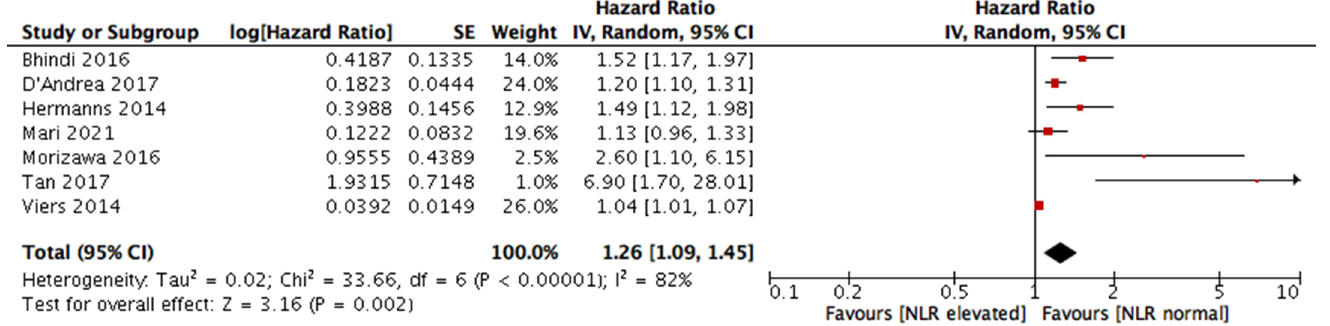
Figure 2. Meta-analysis results of neutrophil-to-lymphocyte ratio (NLR) and its impact on the recurrence-free survival (RFS) of urothelial carcinoma patients after RC [20–22,32,33,36,45].